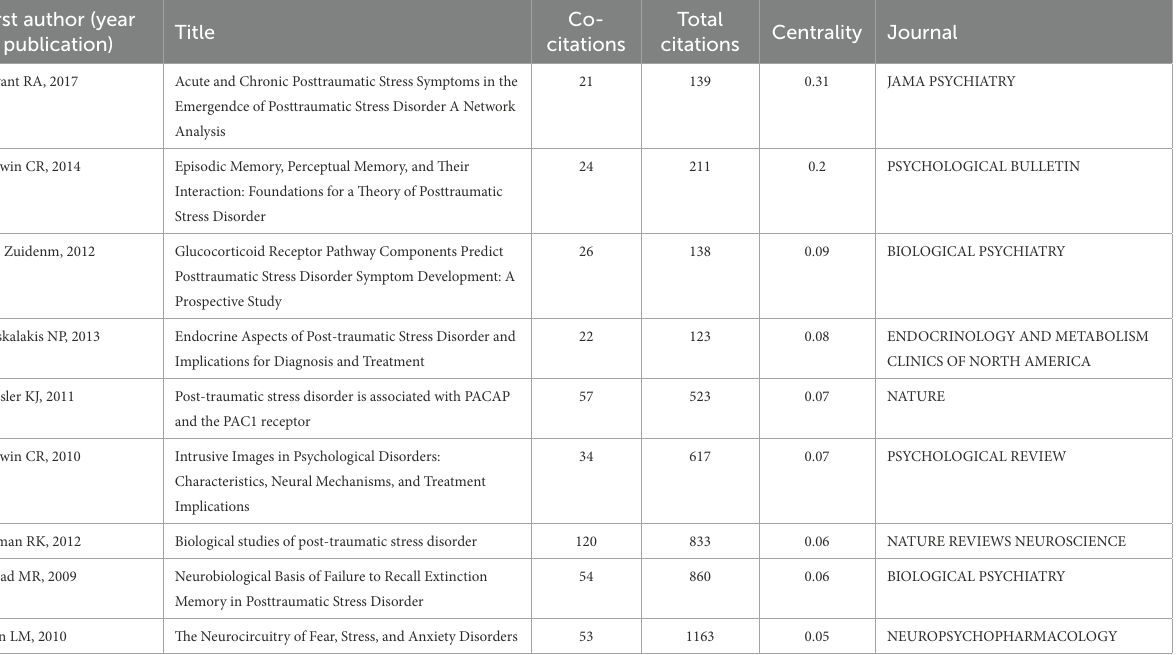
TABLE 4 Turning point articles in the field of